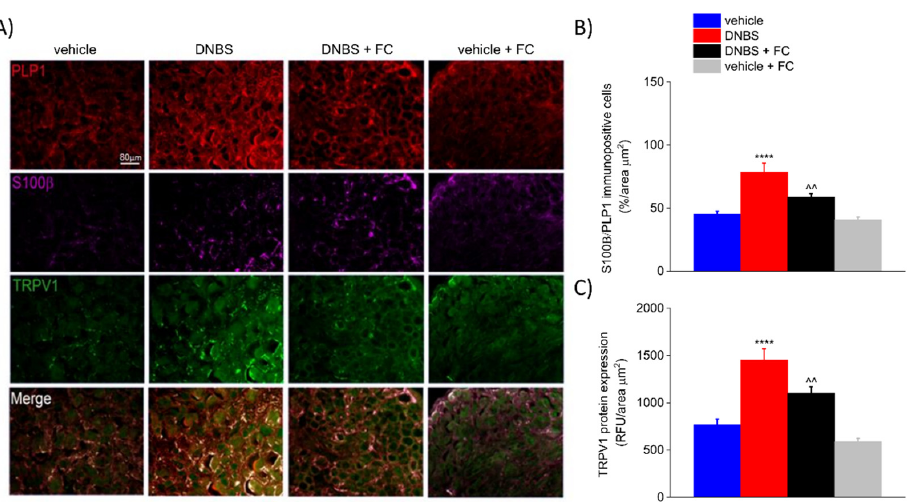
Figure 6. Effect of systemic fluorocitrate on S100 β and TRPV1 increased expression in the DRG of DNBS rats at day 7. ( A ) Representative images show the expression of PLP1 (red), S100 β (purple), and TRPV1 (green) in the DRG and ( B , C ) relative immunolabeling quantification at day 7 after colitis induction. Data were analysed by one-way ANOVA and Bonferroni post-hoc. Results are expressed as a mean ± SEM of the percentage of PLP1 immunopositive cells that express S100 β per area unit ( μ m 2 ) of n assessments. Results about TRPV1 expression are expressed as average relative fluorescence units (RFUs) ± SEM per area unit of ( μ m 2 ) of n assessments. **** p < 0.0001 vs. vehicle and ^^ p < 0.01 vs. DNBS. Original magnification: 10×. Scale bar: 80 μ m.